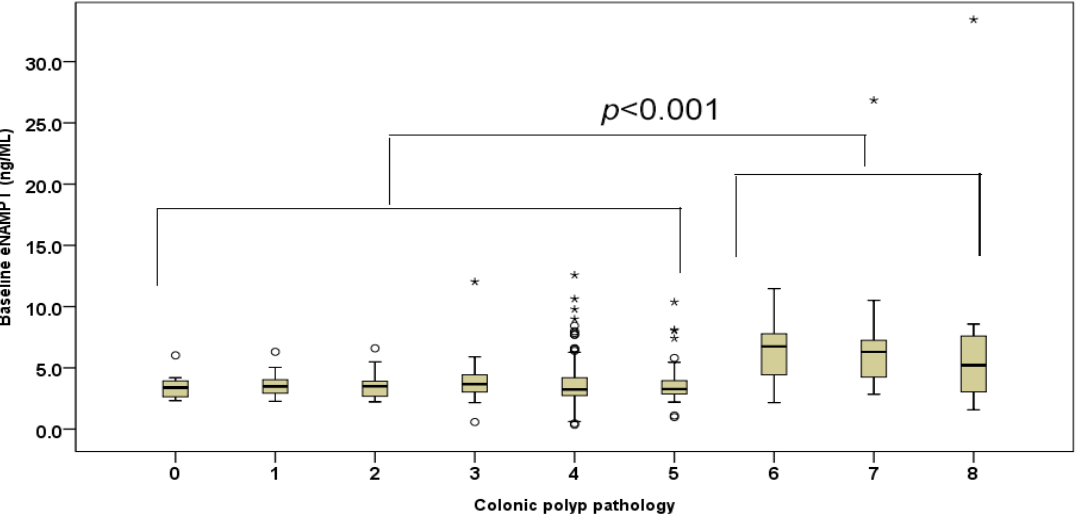
Figure 1. Bart charts (95% CI) of serum eNAMPT levels in patients stratified by polyp pathology. 0, no polyp; 1, inflammation, muscle prolapse, or juvenile polyp; 2, hyperplastic polyp; 3, sessile serrated adenoma (SSA); 4, tubular adenoma; 5, tubulovillous adenoma; 6, villous adenoma; 7, adenoma with high-grade dysplasia; and 8, adenocarcinoma.